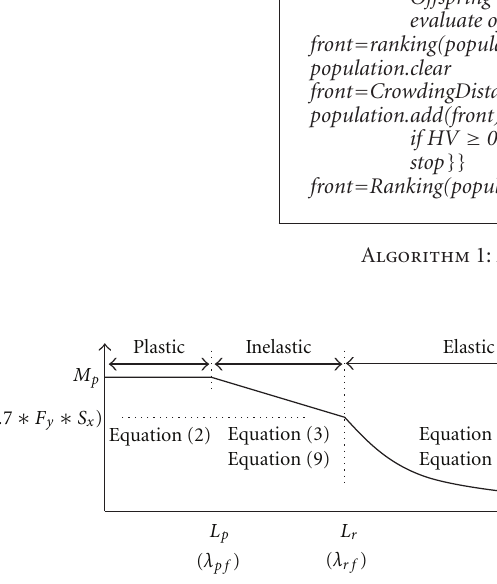
Figure 1: Nominal flexural strength as a function of “flange width- thickness ration of rolled I-shapes” and “unbraced length and moment gradient” (it corresponds to Figure C-F1.1 and C-F1.2.1 in the design manual of AISC-LRFD Ver.13).